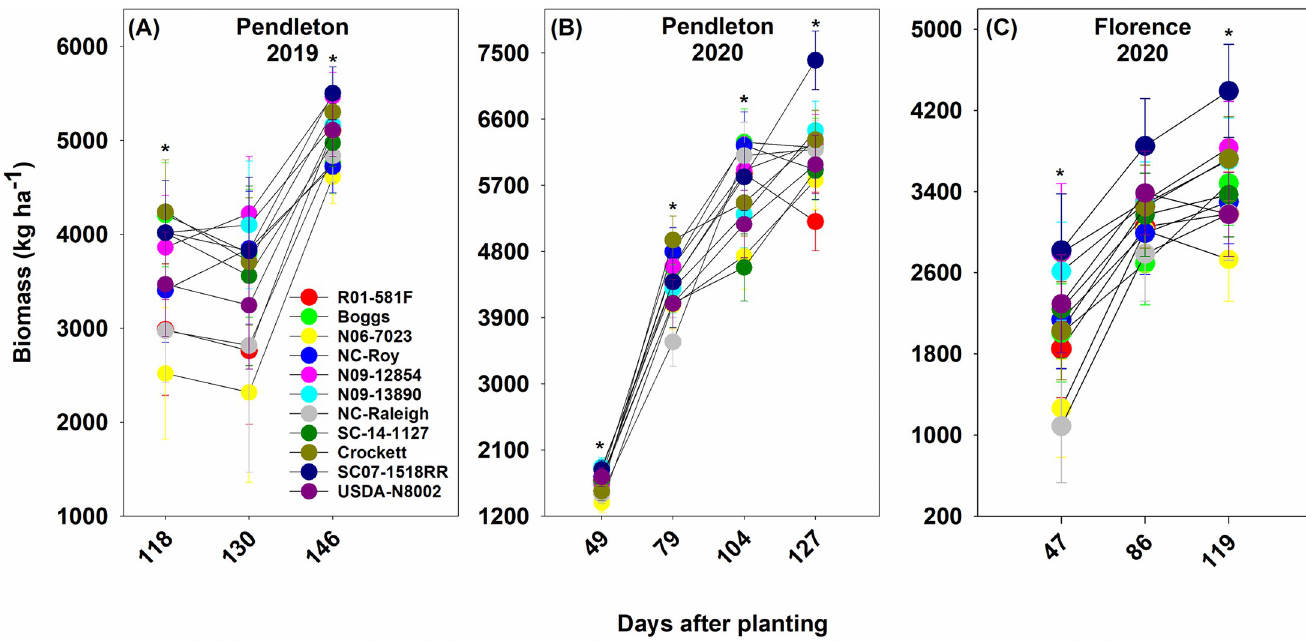
Fig 2. Biomass production of the soybean genotypes at Pendleton (2019, Panel A and 2020, Panel B) and Florence (2020, Panel C) in South Carolina. Biomass was not measured at Florence in 2019. Asterisk shows differences among genotypes based on the Fisher’s least significant difference (LSD) test at α = 0.05. Most genotypes reached R4 growth stage by 118 days after planting (DAP) and R7 or R8 growth stage by 146 DAP at Pendleton in 2019. Most genotypes reached V8, R4, R5, and R6 growth stages by 49, 79, 104, 127 DAP, respectively, at Pendleton in 2020. Most genotypes reached V7, R5, and R7 growth stages by 47, 86, and 119 DAP, respectively, at Florence in 2020. Growth stages were determined following Fehr and Caviness